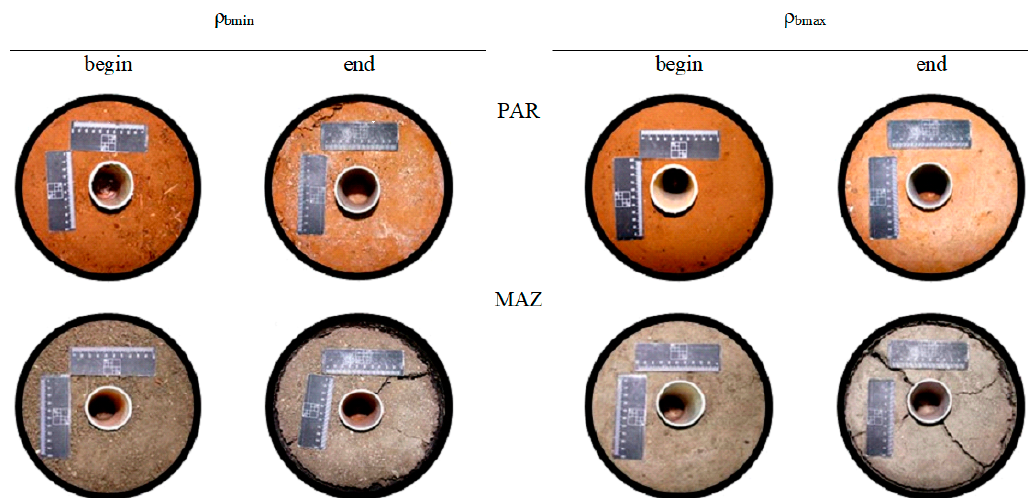
Figure 3. Images of the repacked monoliths at the beginning of the drying process and after oven-drying for soils of Partinico (PAR) and Mazara del Vallo (MAZ).